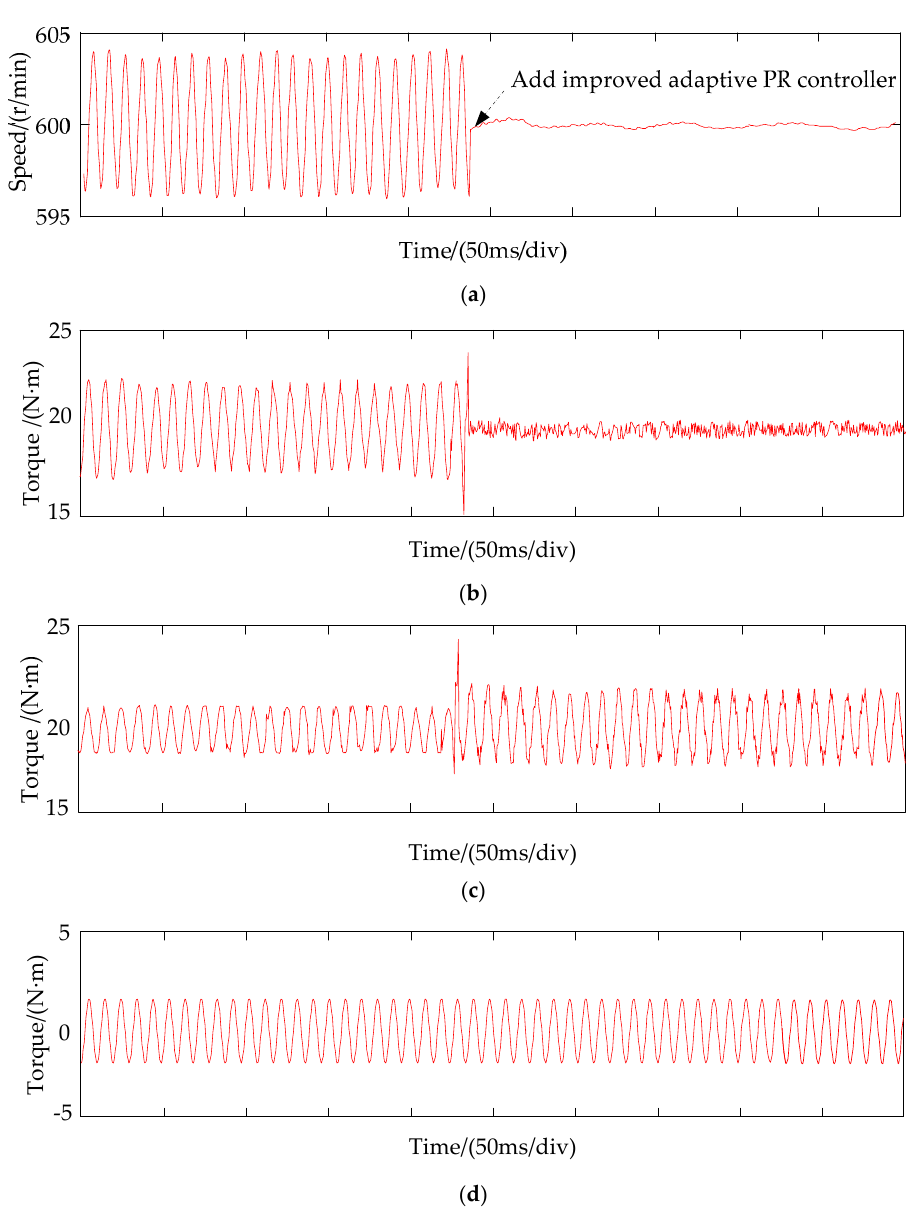
Figure 16. The experimental waveform: ( a ) The waveform of speed; ( b ) The output electromagnetic torque; ( c ) The electromagnetic torque of normal windings; ( d ) The electromagnetic torque produced by short-circuited coils.